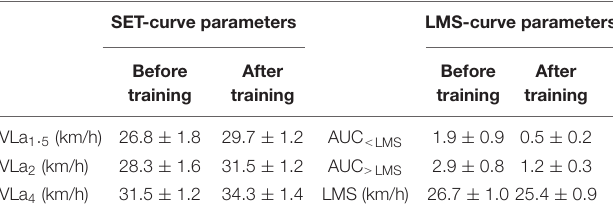
8 weeks of training. SET-curve